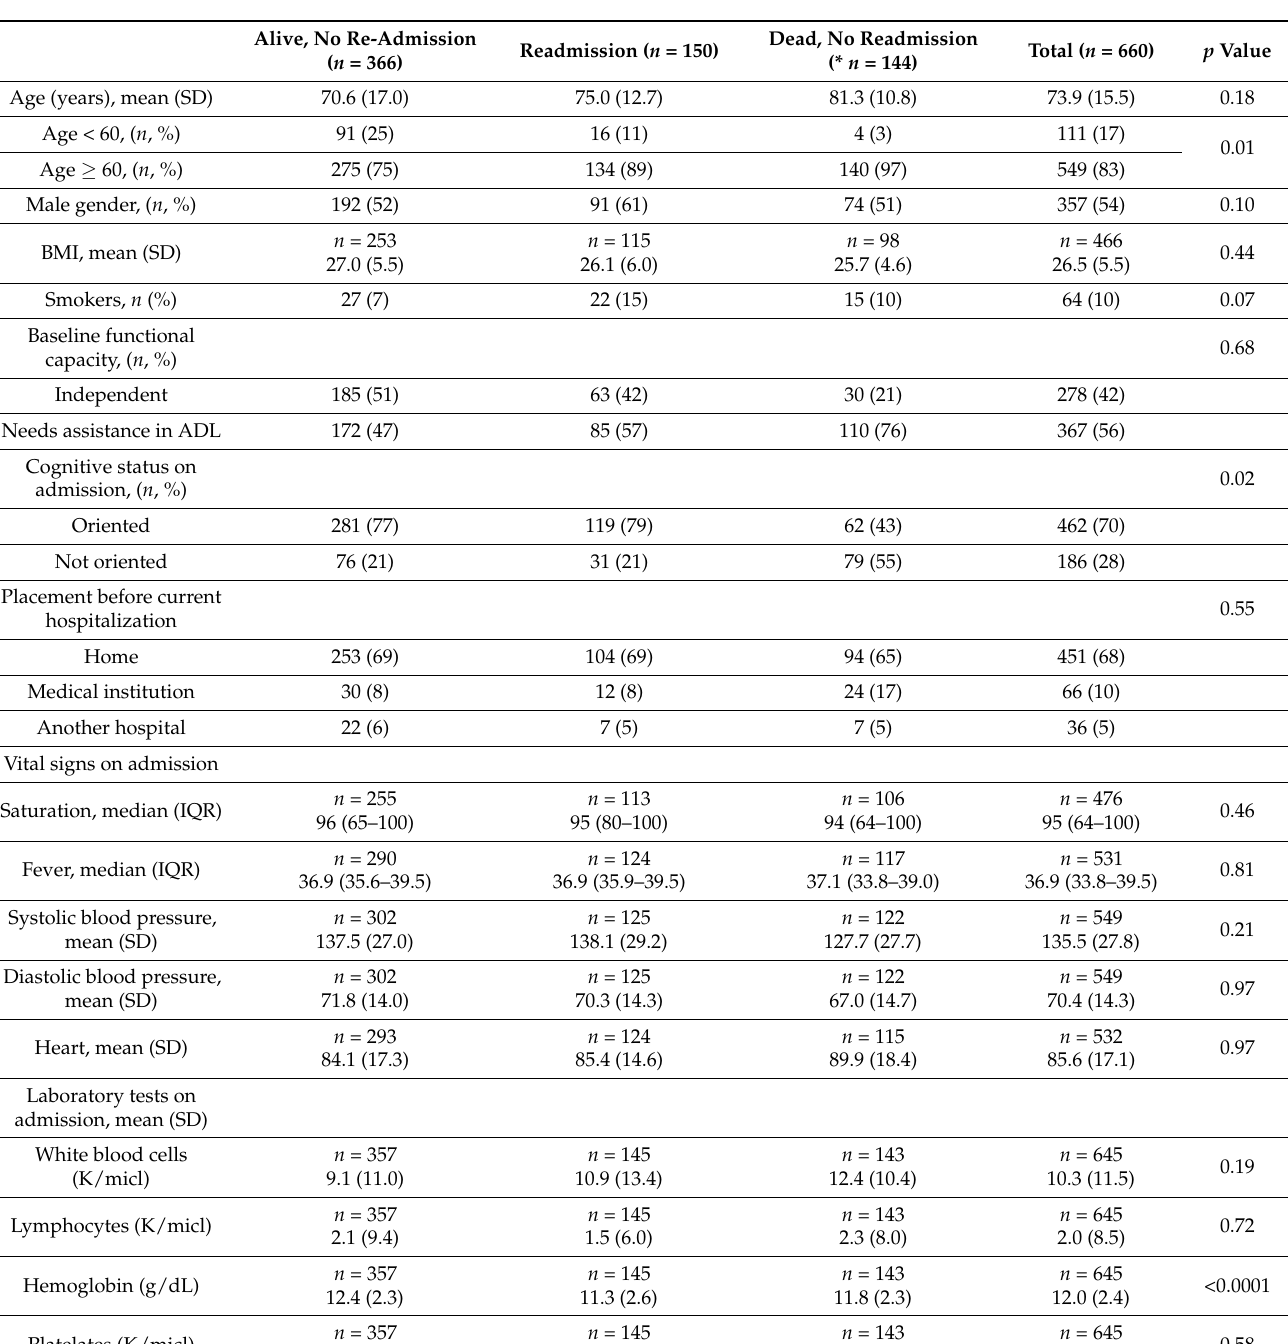
Table 1. Baseline characteristics of the study cohort: re-admitted patients compared with those who were not